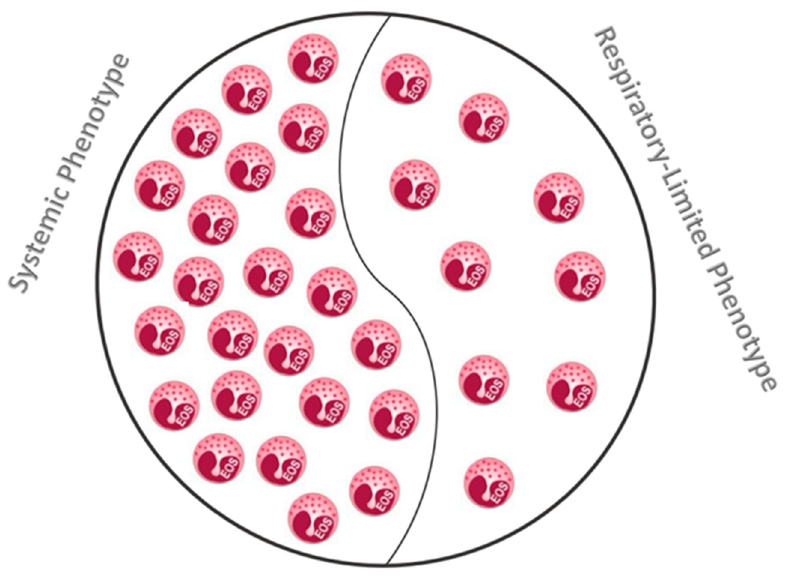
Figure 5. Schematic representation of the predictive value of eosinophils in distinguishing the respiratory-limited and systemic EGPA phenotypes.